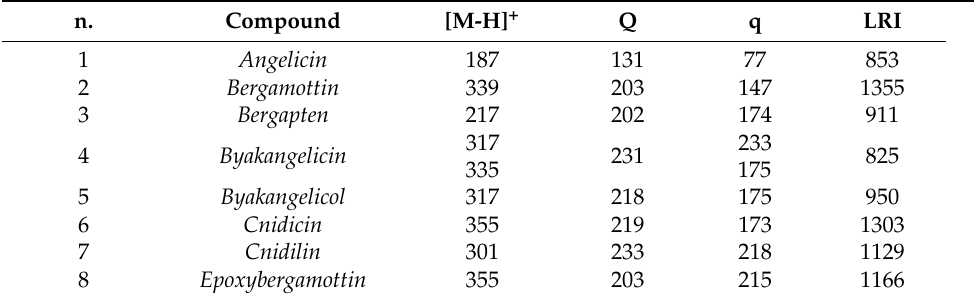
Table 3. Oxygen heterocyclic compounds contained in the samples analyzed, with MRM transitions and linear retention index (LRI)